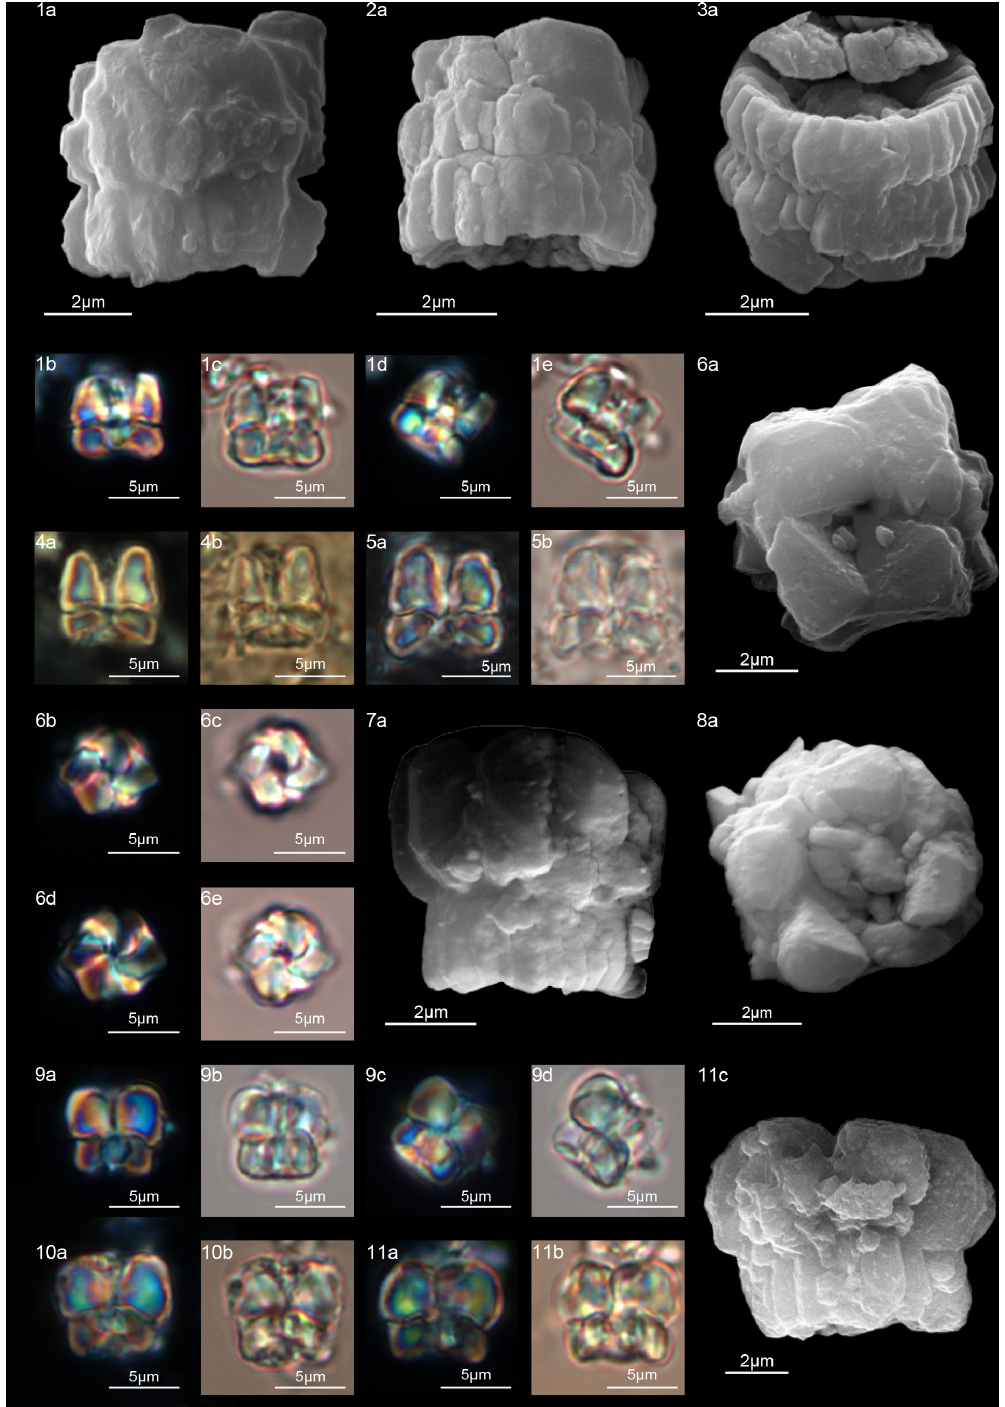
Figure 11. Diantholitha alata . (1) Sample: 1209C 14-1, 116–117. (1a) SEM, (1b, d) XPL, (1c, e) PPL. (2) Sample: 1262C 11-2, 56–57. (2a) SEM. (3) Sample:1262C 11-2, 56–57. (3a) SEM, proximal view. (4) Sample: 1262B 20-5, 2–3. (4a) XPL, (4b) PPL. (5) Sample: 1262B 20-5, 5–6. (5a) XPL, (5b) PPL. (6) Sample: 1209C 14-1, 84–85. (6a–e) Distal view. (6a) SEM, (6b, d) XPL, (6c, e) PPL. Diantholitha toquea . (7) Holotype (IGF 104720). Sample: 1262 11-2, 56–57. (7a) SEM. (8) Sample: 1262C 11-2, 56–57. (8a) SEM, distal side. (9) Paratype (IGF 104721). Sample 1209C 14-2, 50–51. (9a, c) XPL, (9b, d) PPL. (10) Sample: 1209 14-2, 50–51. (10a) XPL, (10b) PPL. (11) Sample: 1209 14-2, 50–51. (11a) XPL, (11b) PPL, (11c) SEM. See Table S1 for sample details.